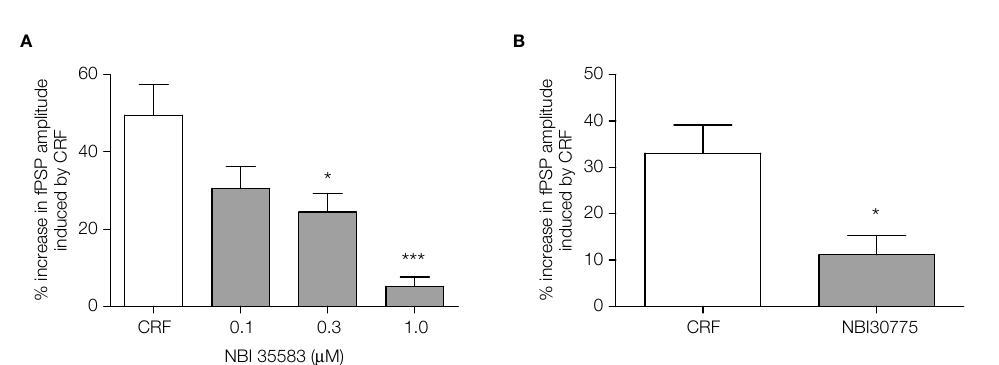
Figure 4 | (A) The CRF1 receptor antagonists NBI 35583 (0.1–1.0 μ M, 20 min before 0.1 μ M CRF); data shown are the mean ± SEM from 12 control slices (11 rats) and 6–9 slices (3–6 rats) pretreated with antagonist at the concentrations indicated. * p < 0.05, *** p < 0.001, one-way ANOVA followed by Bonferroni t -test. (B) NBI 30775 (1 μ M, 20 min before CRF) blocked the increase in fPSP amplitude induced by 0.1 μ M CRF; data shown are the mean ± SEM from 9 control slices (7 rats) and 6 slices (6 rats) pretreated with the antagonist. * p < 0.05, unpaired t -test.